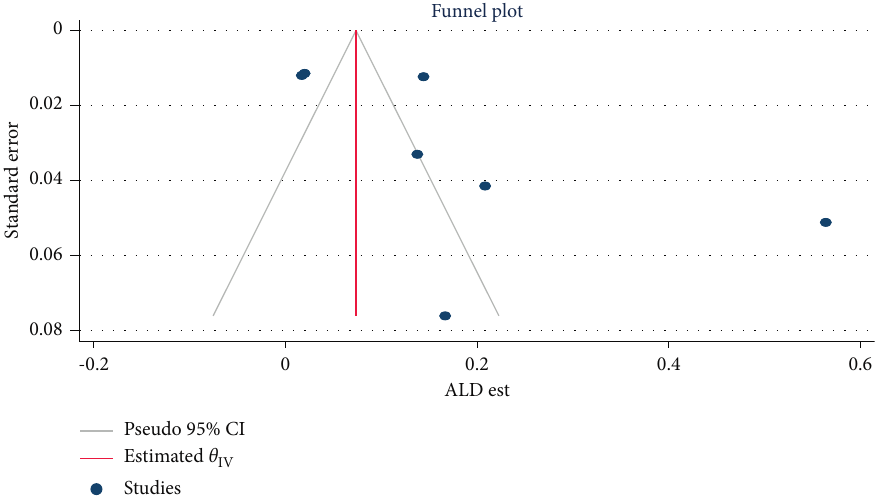
Figure 4: Funnel plot for assessing publication bias across alcoholic hepatitis estimates among chronic liver disease patients in Ethiopia,